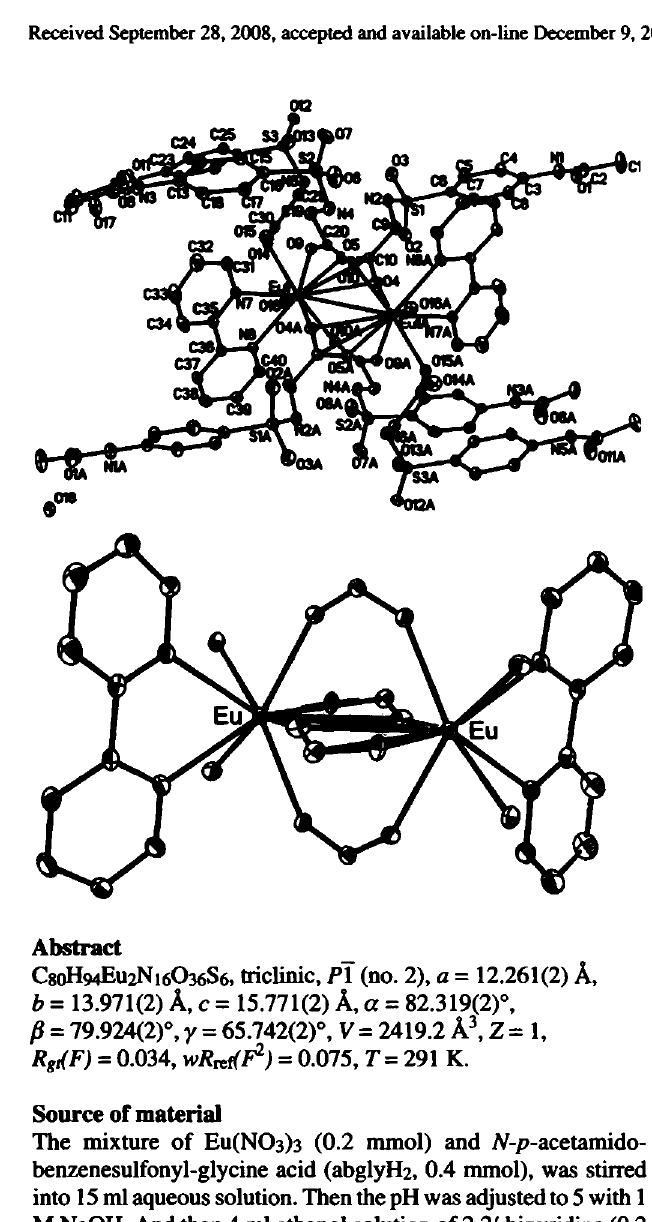
Table 1. Data collection and